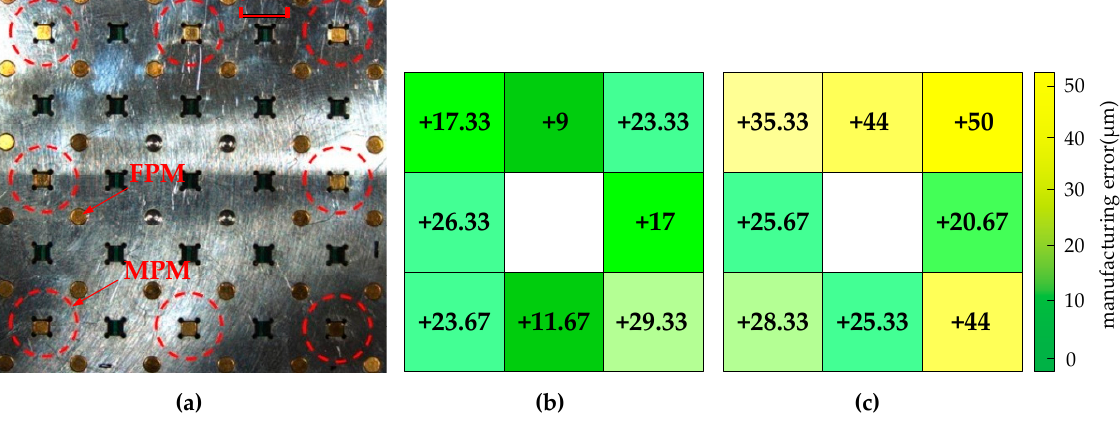
Figure 7. ( a ) Experimental Prototype made of aluminum. ( b ) Manufacturing errors along x -axis of the square cavities. ( c ) Manufacturing errors along y -axis of the square cavities.